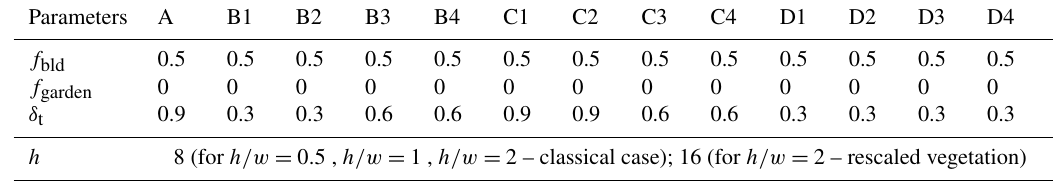
Table 2. List of input parameters for the ensemble of simulations performed with TEB.